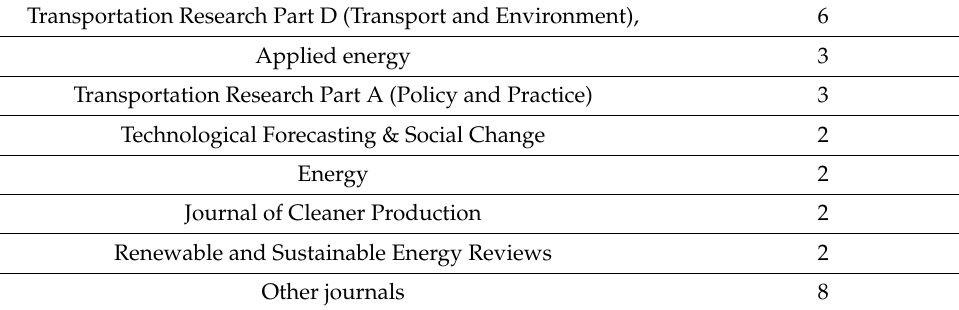
Table 1. List of journals covering the social aspect of electric vehicles (EVs).